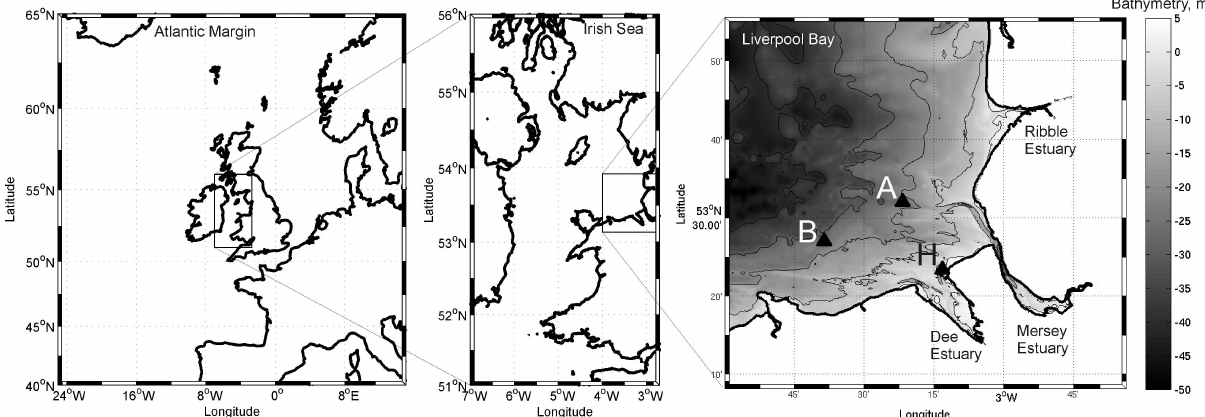
Fig. 2. The Atlantic Margin model domain (left), nested Irish Sea model domain (middle), and nested Liverpool Bay domain (right) with model bathymetry (in m below the mean tidal level) shown as 10m contours and the mooring locations marked as triangles: Site A (A), Site B (B) and Hilbre